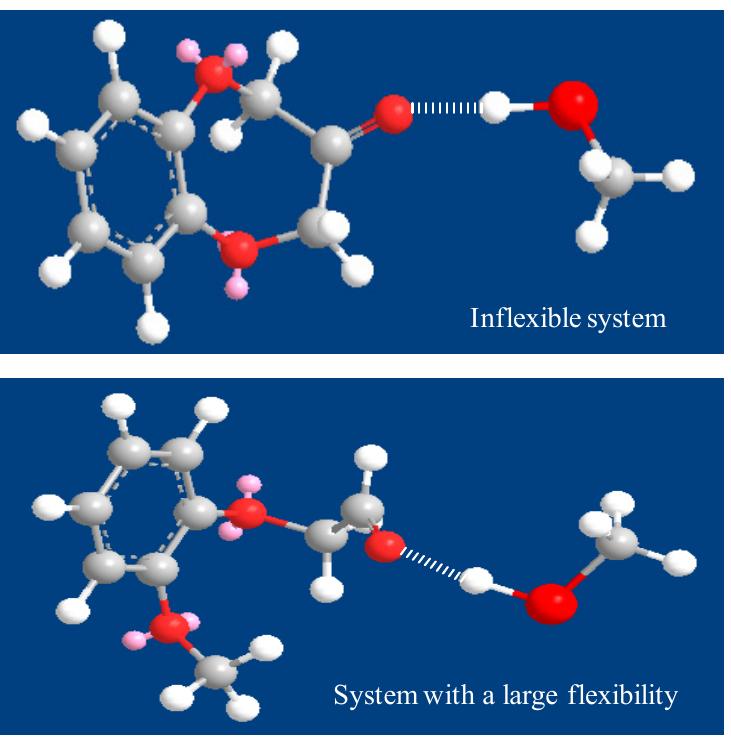
Figure 5. Flexiblity of the system in relation to the seven-membered cycle.